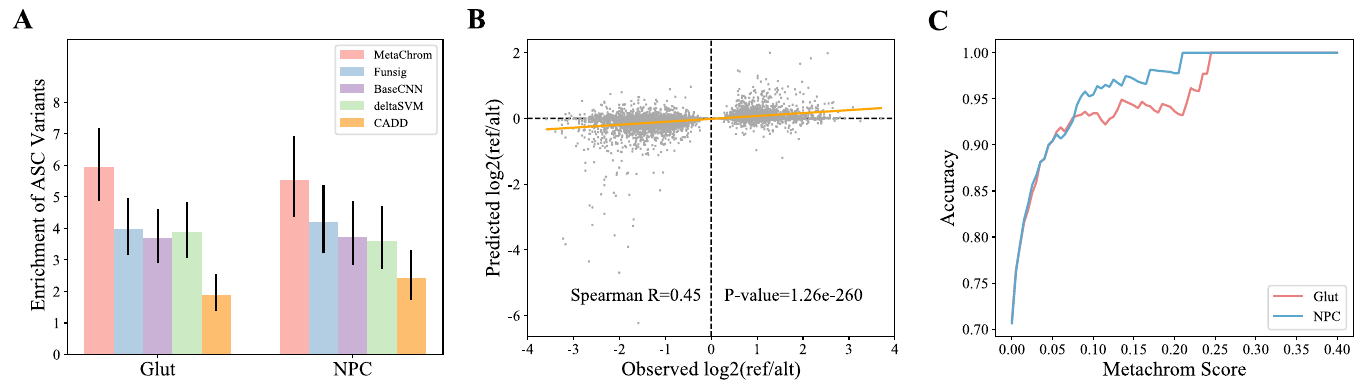
Fig 4. Validation of MetaChrom predicted functional variants with ASC variants. (A) Enrichment of ASC variants for predicted functional variants identified by MetaChrom, Funsig, CADD, deltaSVM, baseline CNN score in iN-Glut and NPC cells. (B) The observed allelic imbalance vs. MetaChrom predicted effects on chromatin accessibility of ASC variants in Glut neurons. (C) Accuracy of predicting directions of ASC variants in Glut and NPC cells.